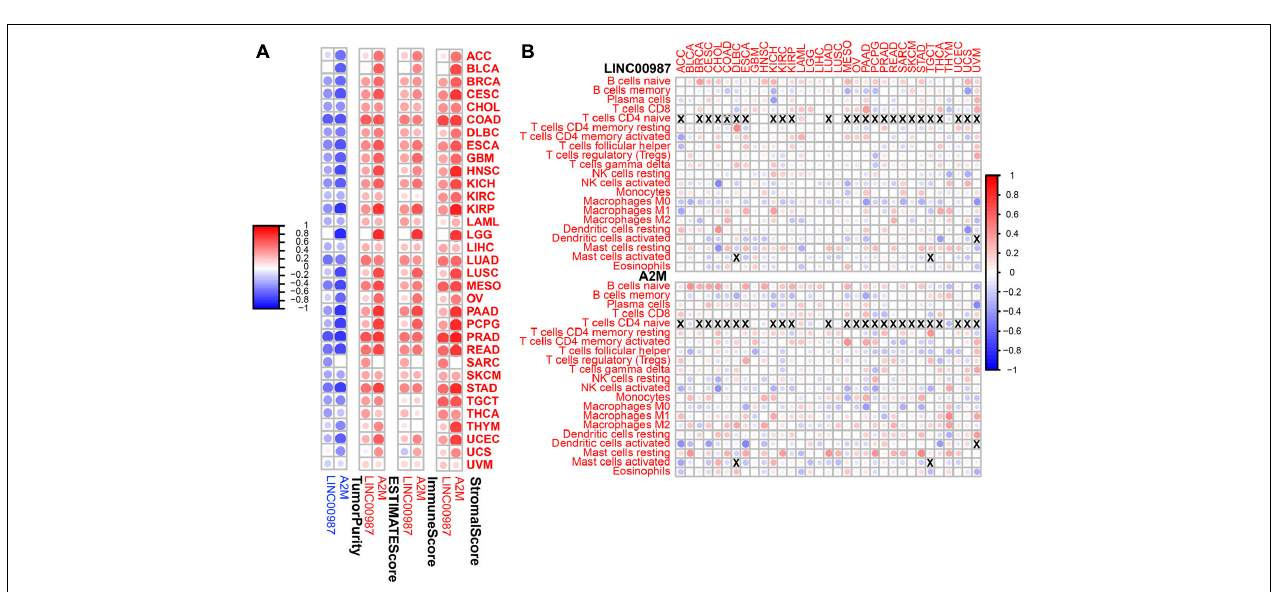
FIGURE 10 | Correlation of alterations in TMB and MSI with the level of expression of LINC00987 and A2M in various tumors. (A,C) Radar chart showing the correlation between LINC00987 and TMB (A) and MSI (C) in 33 cancer types. (B,D) Relationship between A2M and TMB (B) and MSI (D) . * p < 0.05, ** p < 0.01, and *** p < 0.001.